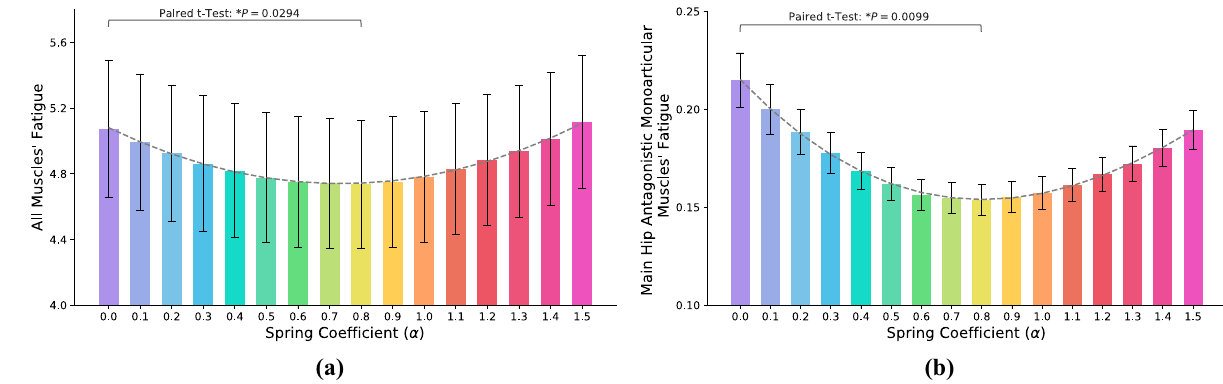
Figure 6. Muscles’ fatigue . ( a ) Shows all 92 muscles’ fatigue versus the stiffness coefficient (N = 7 ; ANOVA; random effect: participant; fixed effects: spring coefficient and square of spring coefficient; P scoef = 0.0343 , P scoef 2 < 0.0001 ). The optimum spring coefficient for the whole muscles’ fatigue reduction is at α # = 0.8 (paired two-sided t test with correction for multiple comparisons; P = 0.0294 ). The dashed line is the quadratic best-fitted profile to average muscles’ fatigue ( R 2 = 0.99 , P < 0.0001 ). ( b ) Shows main hip antagonistic mono- articular muscles fatigue versus the stiffness coefficient (N = 7 ; ANOVA; random effect: participant; fixed effects: spring coefficient and square of spring coefficient; P scoef < 0.0001 , P scoef 2 < 0.0001 ). The optimum spring coefficient for the mono-articular muscles’ fatigue reduction is at α # = 0.8 (paired two-sided t test with correction for multiple comparisons; P = 0.0099 ). The dashed line is the quadratic best-fitted profile to average muscles’ fatigue ( R 2 = 0.99 , P < 0.0001 ). Comparing ( a ) and ( b ) shows that stiffness coefficient optimization based on feedback from mono-articular muscles leads to whole muscles’ fatigue reduction.